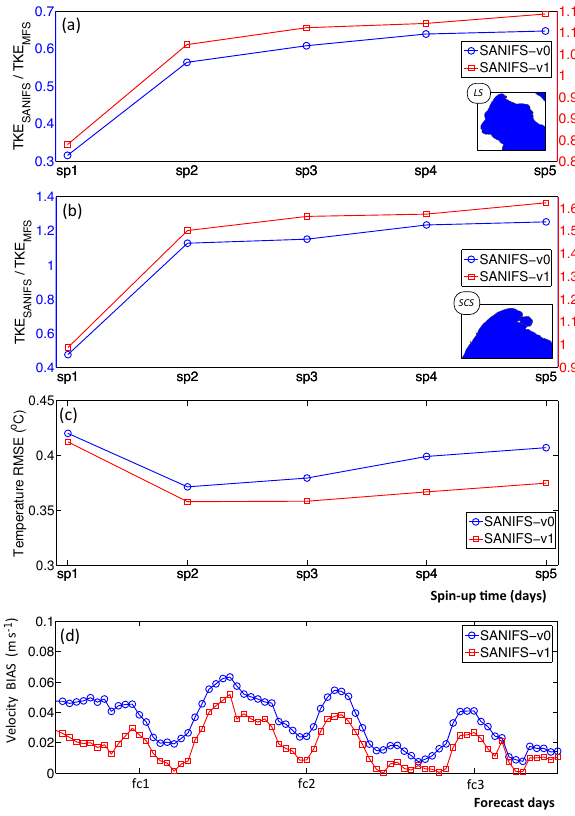
Figure 5. TKE ratio between downscaled model (SANIFS) and par- ent model (MFS) as function of spin-up time, calculated on the large scale LS (a) and shelf-coastal scale SCS (b) . Temperature RMSE (model vs. satellite SST) in the Gulf of Taranto as a function of spin- up time (c) . Velocity bias (ms − 1 ) calculated against hourly veloc- ities measured at station P1 (Fig. 4) in Mar Grande of Taranto (d) . SANIFS-v0 refers to the experiment initialized through tracer fields. SANIFS-v1 refers to the experiment initialized through tracer and hydrodynamic